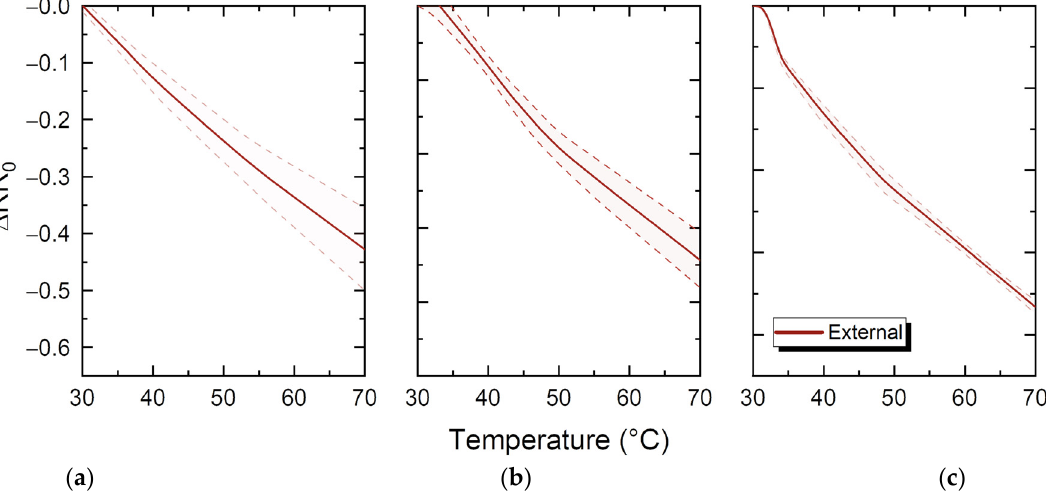
Figure 12. Normalised temperature–resistance relationship for the f –rGO printed samples of ( a ) 2.5 wt%; ( b ) 5 wt%; ( c ) 10 wt% (average of all printing passes with standard deviation band) for external thermal evaluation.